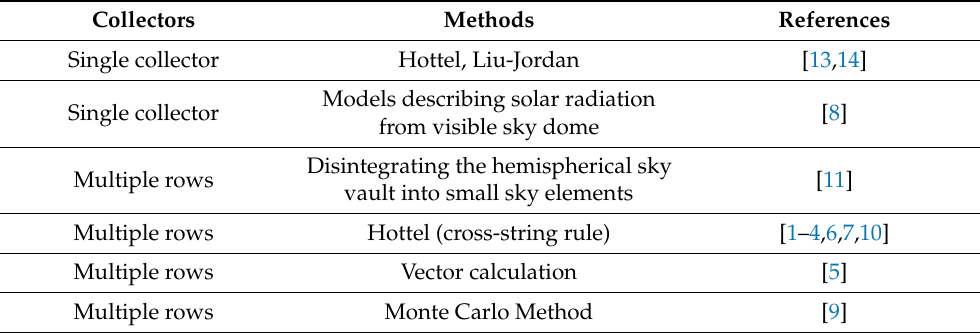
Table 1. Sky view factor: methods and